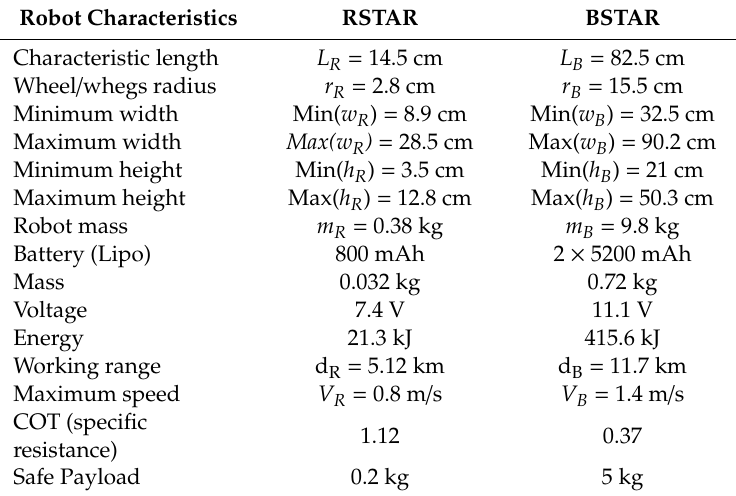
Table 1. The main specifications of RSTAR and